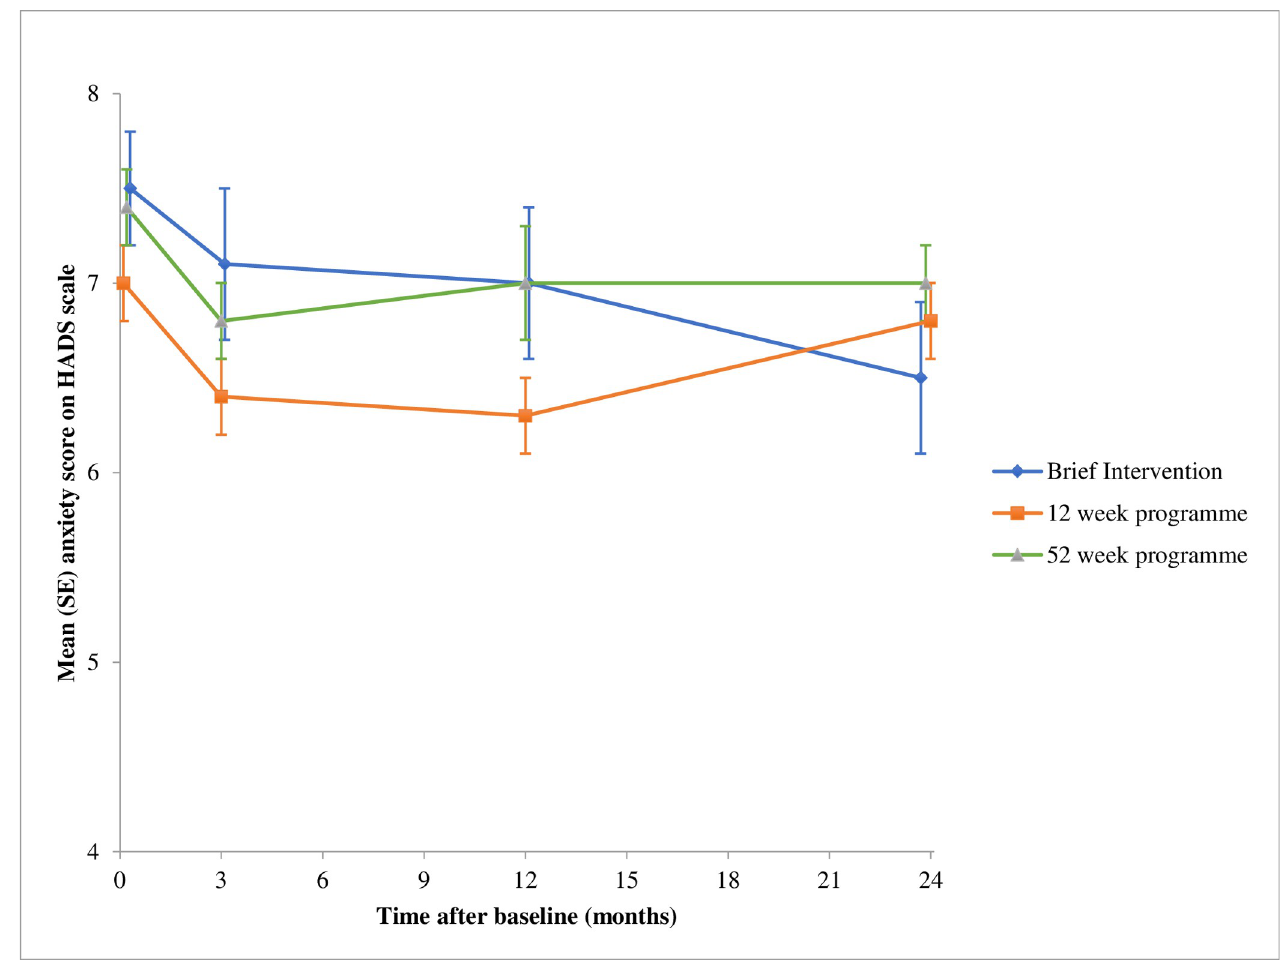
Fig 3. Anxiety score over 24 months of follow-up. Data are mean (standard error) of all measured HADS at each time point (Table 2).